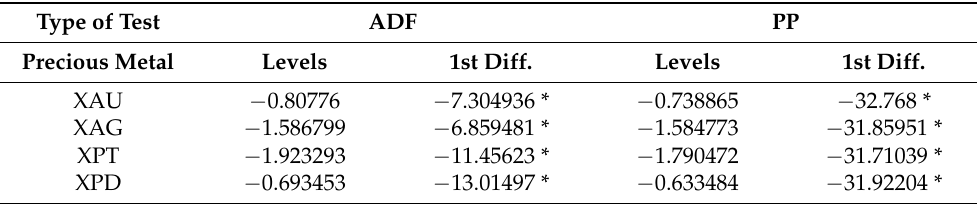
Table A2. The Results of the Unit Root Tests of Precious Metal Prices.